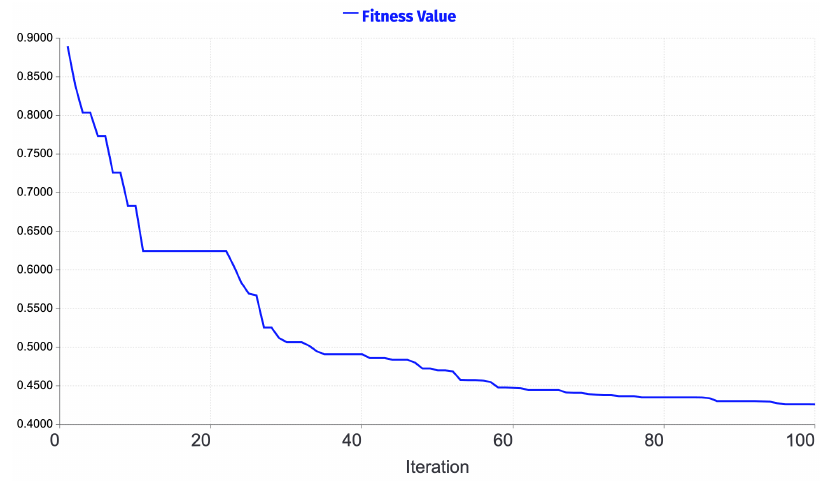
Figure A18. The training convergence curve when using the ANN with the CSO and the cost sensitivity fitness function for the dataset of Polish